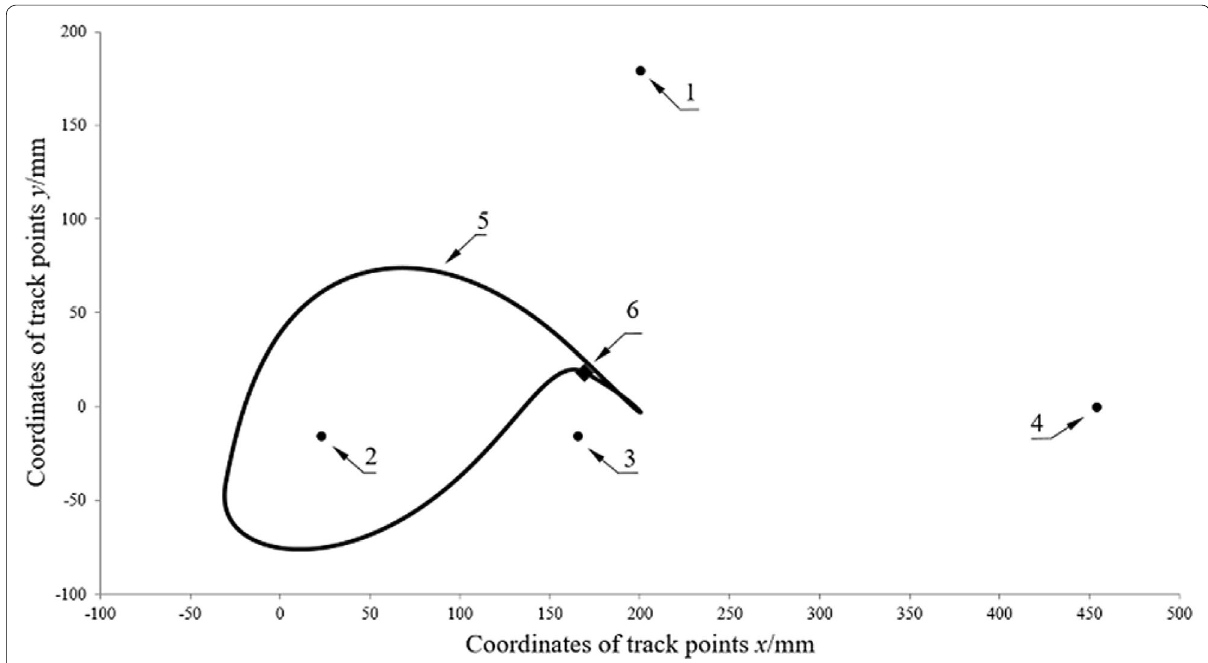
Figure 4 Solution set of the points in the same coordinate system, and plot of the seedling trajectory: 1. Point (200.4036, 179.2269), 2. Point (23.2990, 15.8986), 3. Point (165.8176, 15.8986), 4. Point (454.0944, 15.8986), 5. Seedling pick-up trajectory curve, and 6. End point P 1 of rod II at − − − point 1